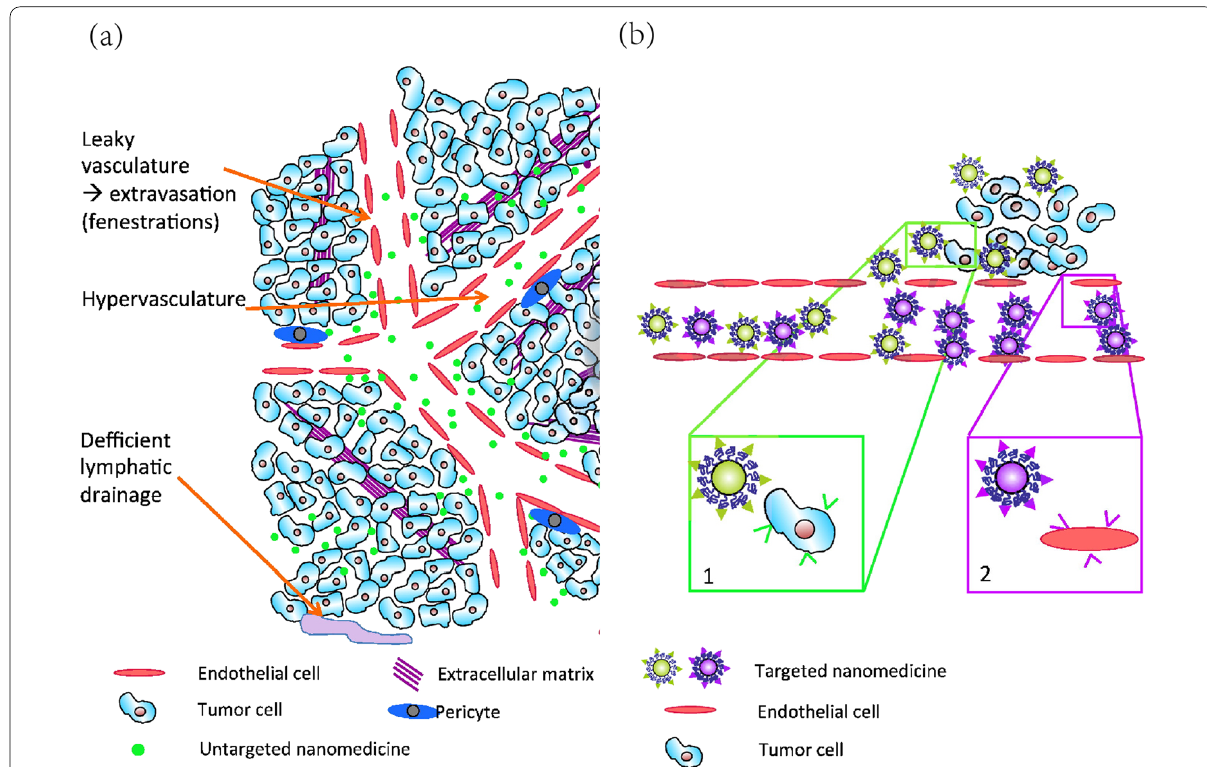
Fig. 9 a Schematic representation of the conceptual passive targeting (EPR effect) of nanomedicine. b Active targeting of nanomedicine grafted with peptide or antibody able to bind specific receptors overexpressed by (1) cancer cells or (2) endothelial cells. Referred from [199] with